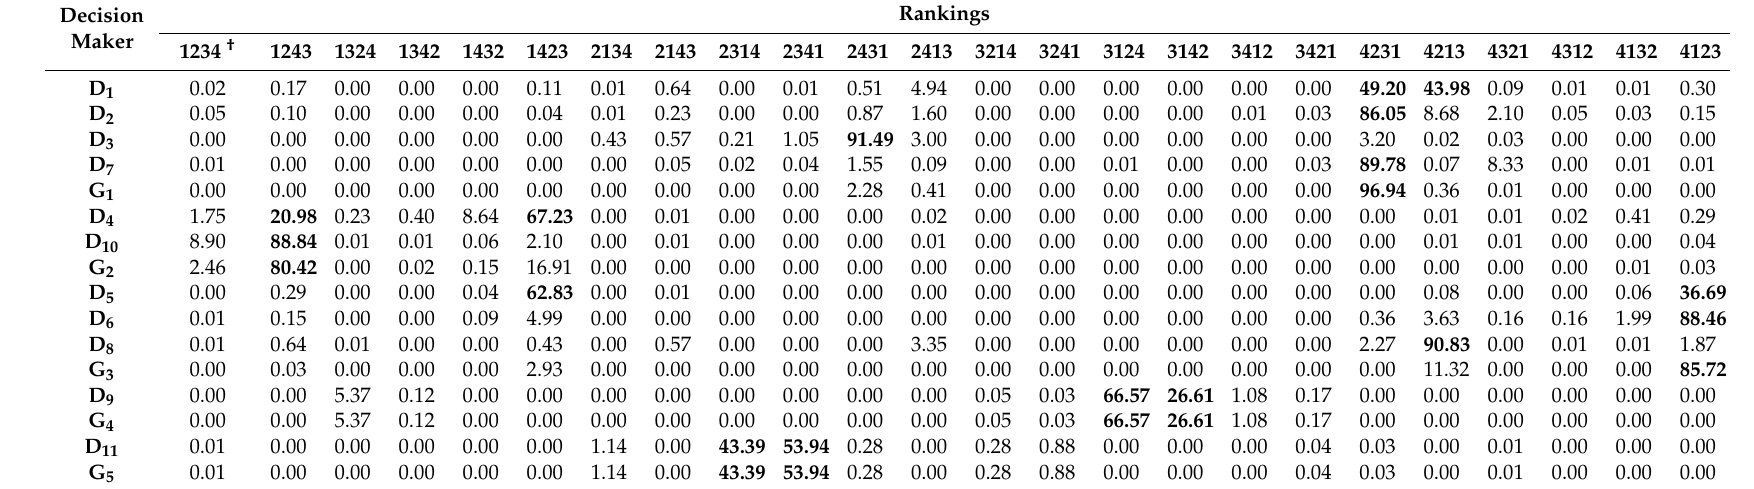
Table 3. Gamma distributions for each decision maker (D i ) and each group (G j ) (probabilities higher than 20% are in